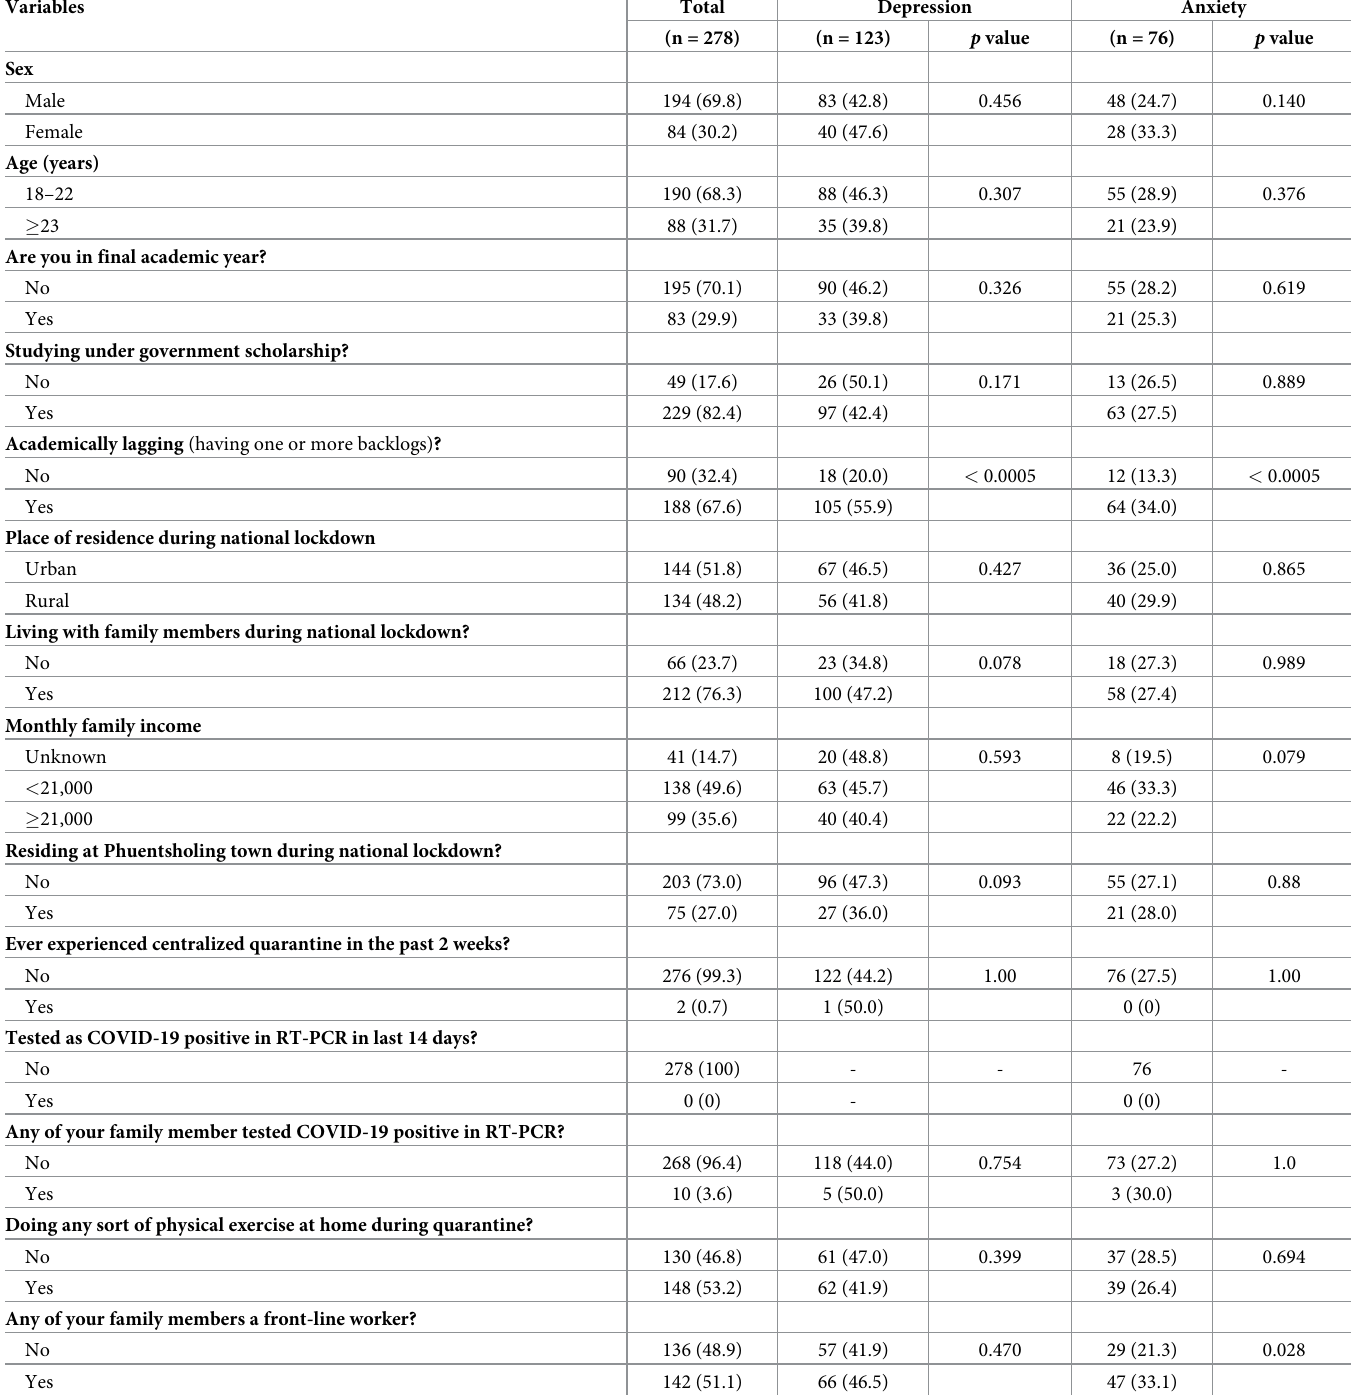
Table 2. Level of depression and anxiety among participants with different socio-demographic characteristics.